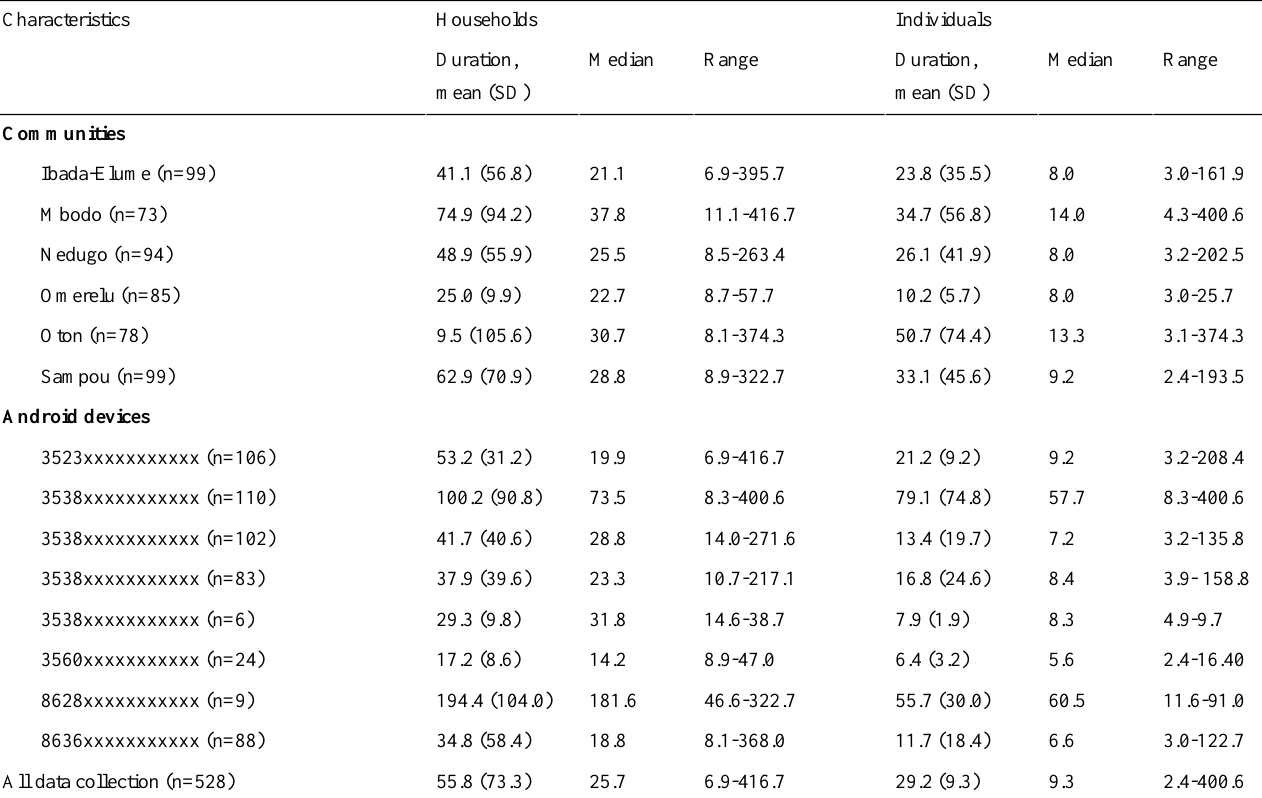
Table 4. Summary statistics for time spent collecting data using Open Data Kit across households and individuals in each community and for each Android mobile